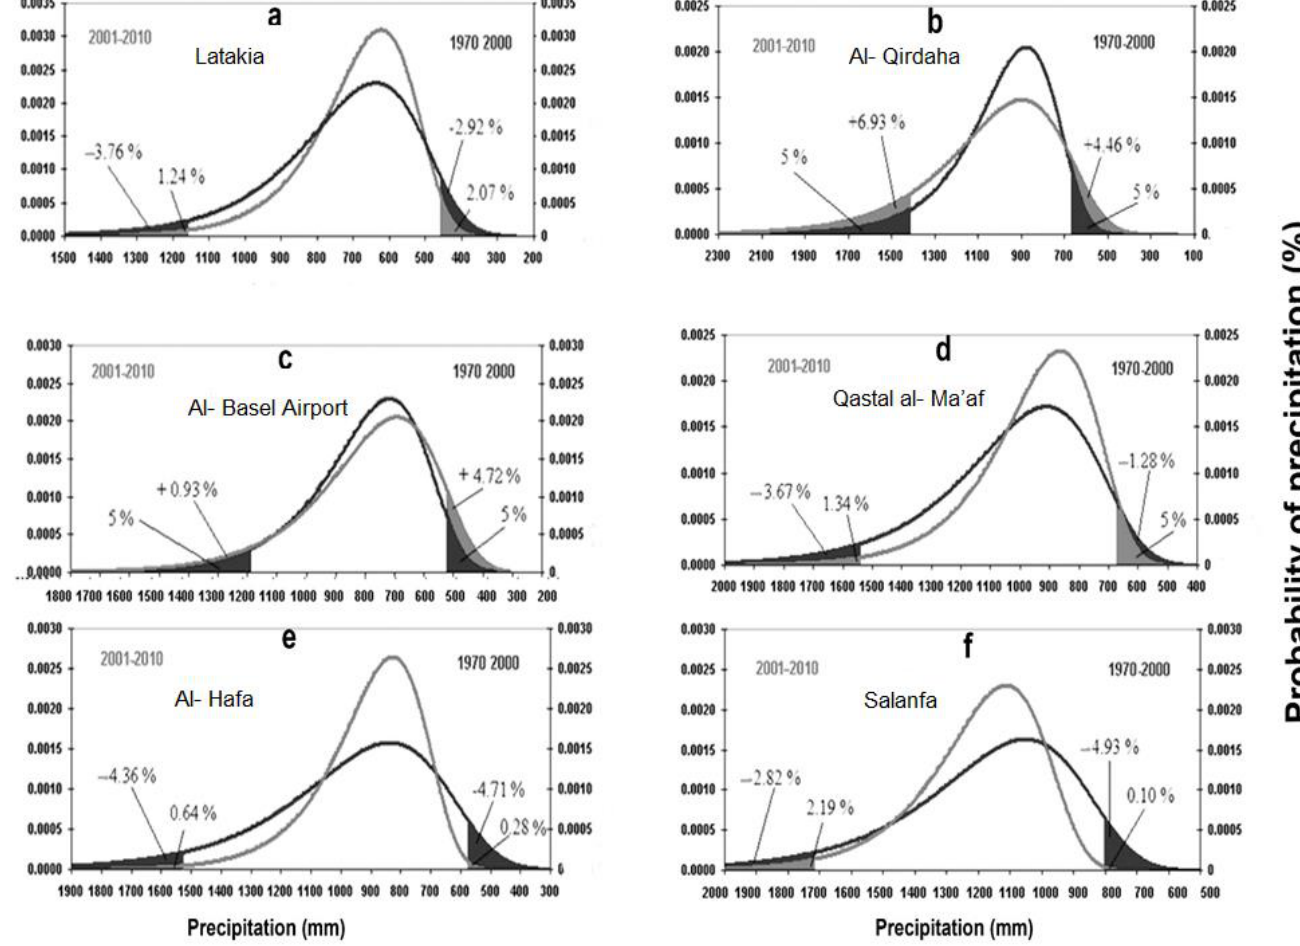
Figure 4. Changes in the potential probability of the annual precipitation average during both time-periods. ( a ) Latakia; ( b ) Al- Qirdaha; ( c ) Al- Basel airport; ( d ) Qastal al-Ma’af; ( e ) Al- Hafa; ( f ) Salanfa